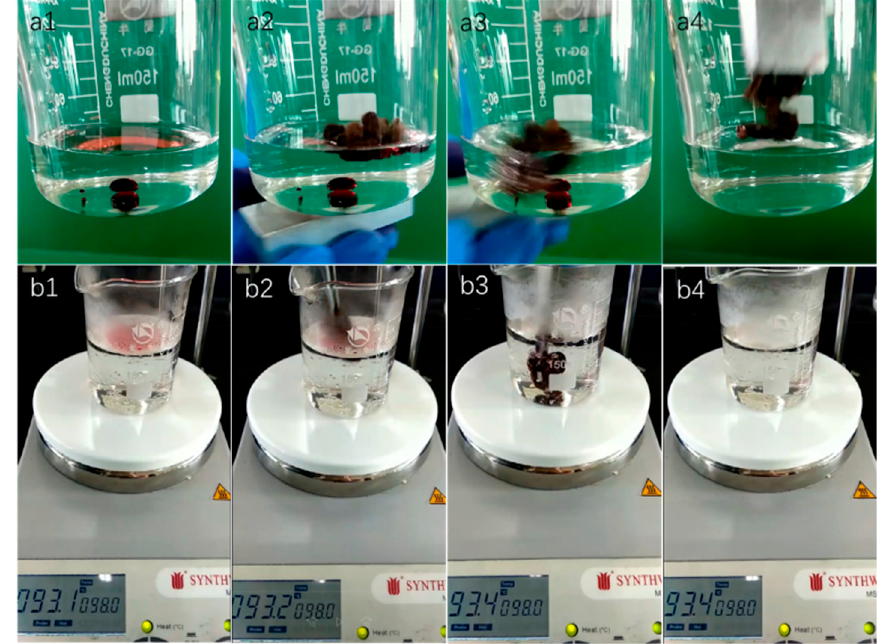
Figure 8. ( a ) Optical images demonstrating the oil/water separation driving by an external magnetic field; ( b ) optical pictures demonstrating the oil/water separation process under hot water at temperatures greater than 90 °C.